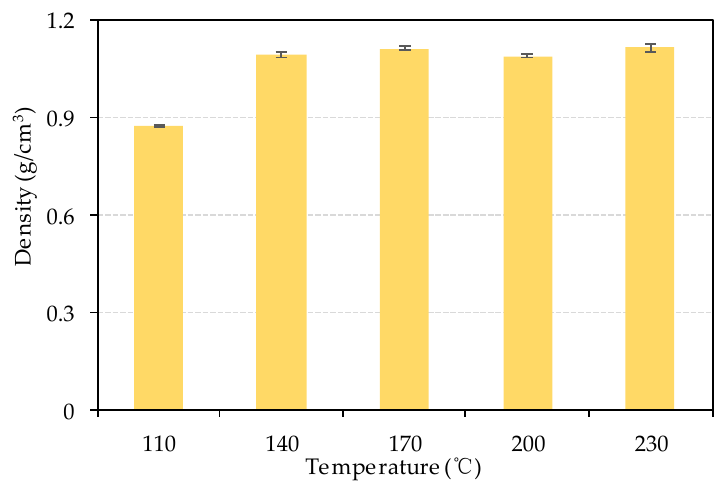
Figure 7. Density of bio-board at different temperature.